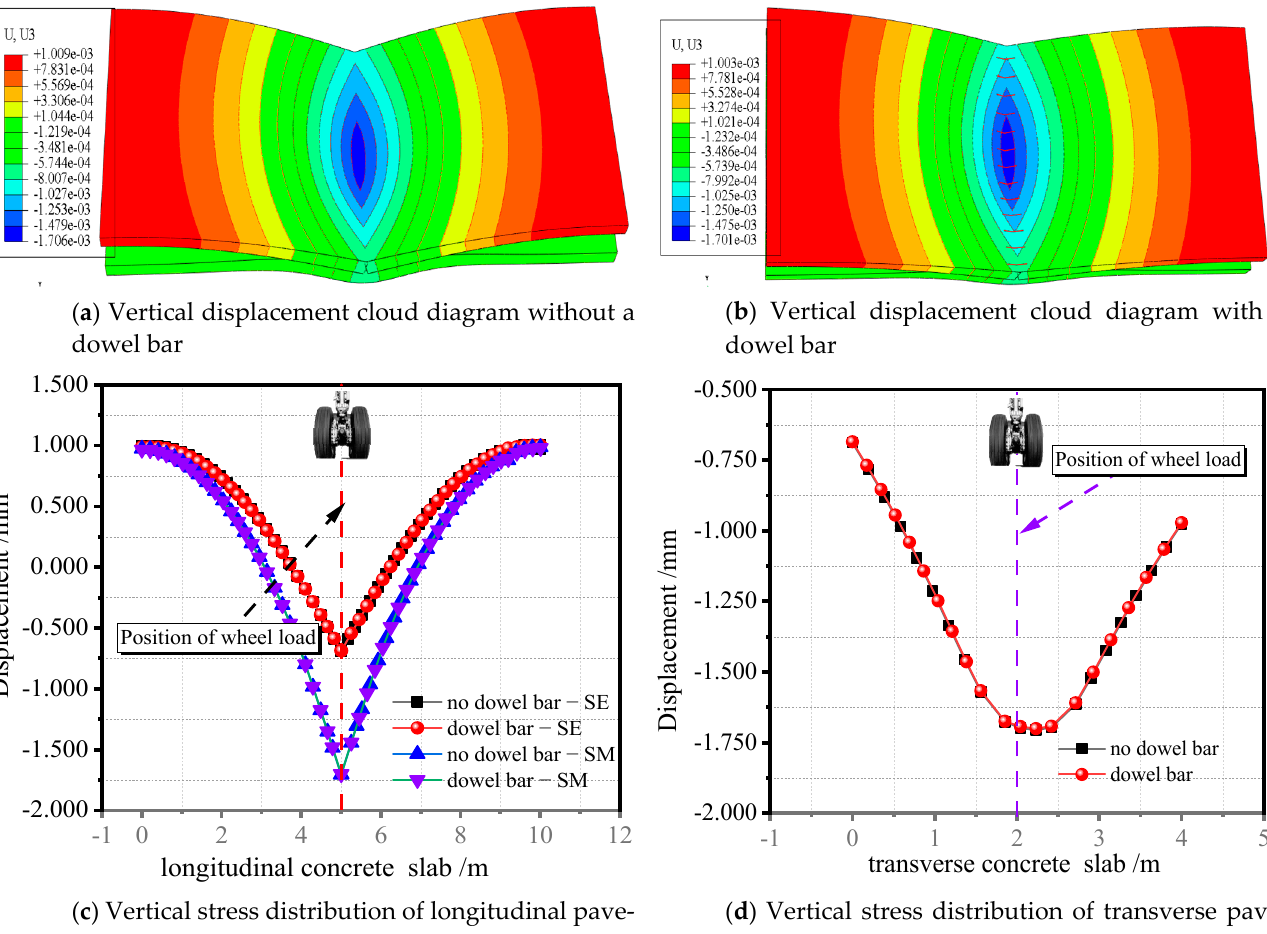
Figure 11. Displacement distribution of the aircraft’s wheel load acting on the joint of the pavement slab.